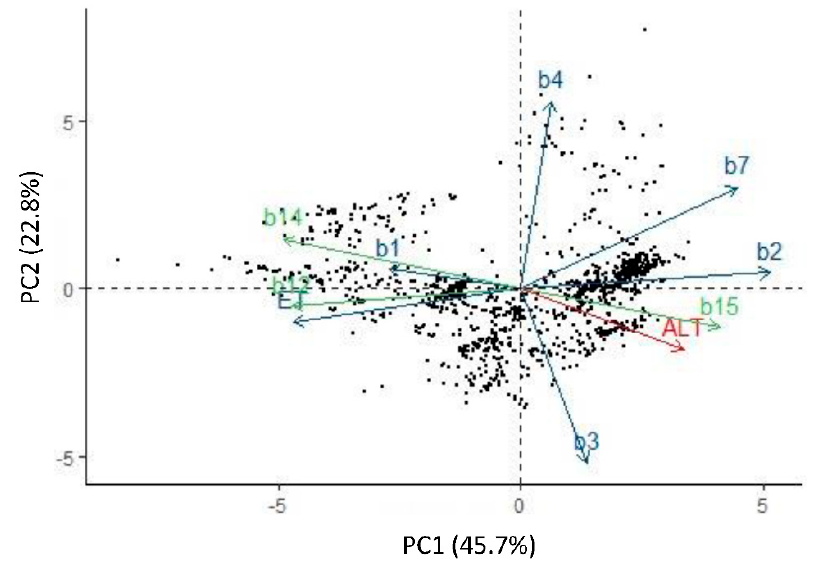
Figure 1. Biplot based on 10 climatic variables and 1296 accessions of S. lycopersicum in Mexico (black dots). PC1 and PC2 explained 45.7 and 22.8% of the total variation, respectively. B1 (annual mean temperature), B2 (mean diurnal range), B3 (isothermality), B4 (temperature seasonality), B7 (temperature annual range), B12 (annual precipitation), B14 (precipitation of the driest month), B15 (precipitation seasonality), ET (annual evapotranspiration), and ALT (digital elevation model). Cluster analysis (CA) was performed in order to group geographic provinces based on the 10 climatic variables considered and Gower distances. The Hopkins statistic indicated evidence (H = 0.073) that there are real clusters. The dendrogram construction